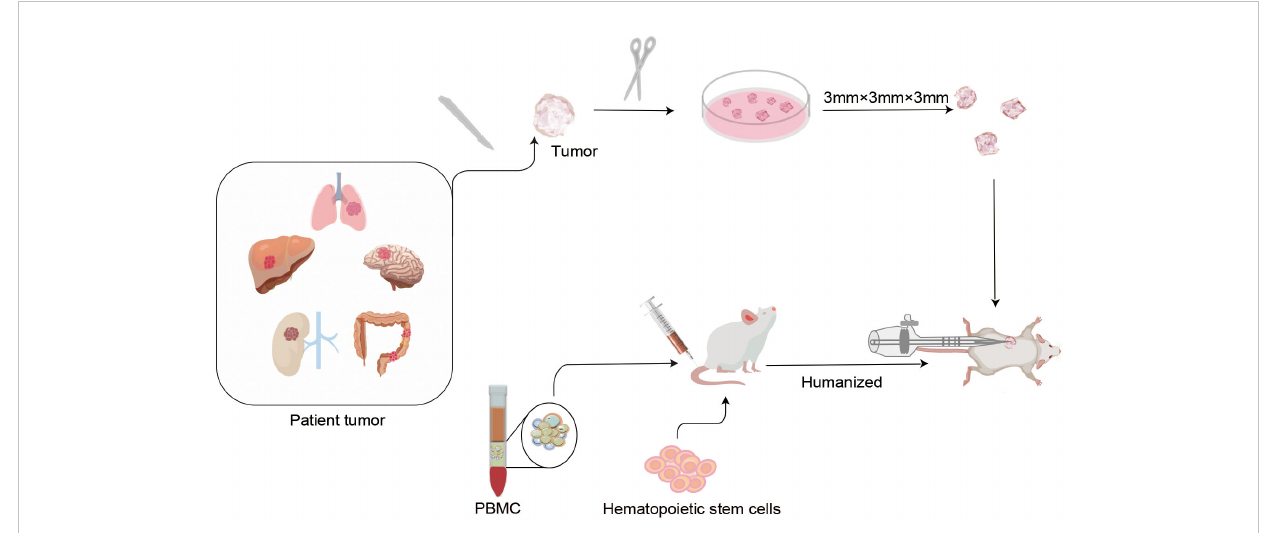
FIGURE 1 Protocols of humanized patient-derived tumor xenografts (PDX) model construction. In the fi rst step, humanized mice were established by transplanting isolated human peripheral blood mononuclear cells (PBMC) or CD34+ human hematopoietic stem cells (HSC), etc. into severely combined immunode fi cient mice. After the human immune system is successfully implanted, a novel humanized PDX model is established by inoculating patient-derived tumor tissues into humanized mice. These types of models not only mimic the phenotypic and molecular characteristics of the original tumor in the patient, but also reproduce the cross-talk between the tumor and the immune system. This is of critical signi fi cance for individualized drug marker screening and drug development for tumor